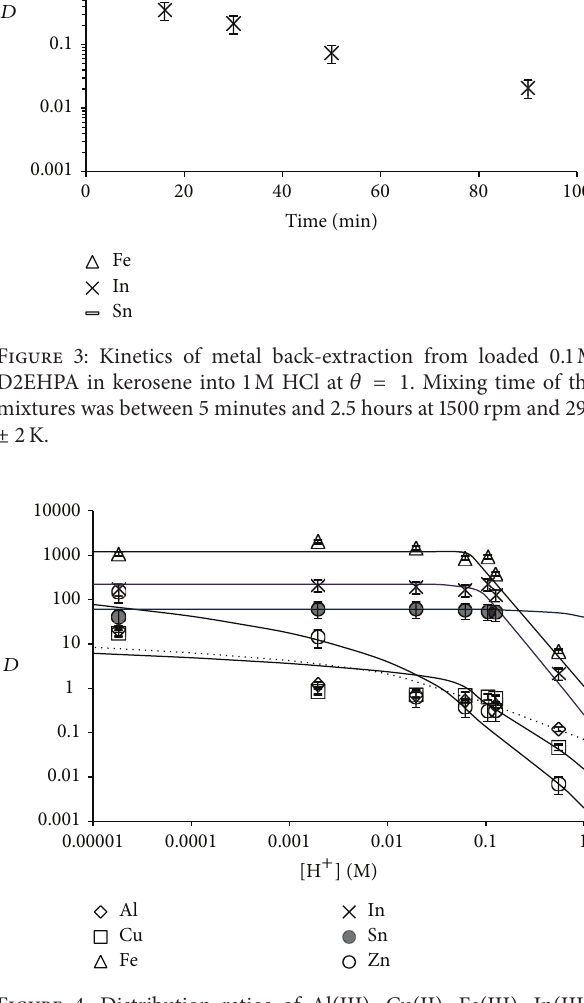
Figure 4: Distribution ratios of Al(III), Cu(II), Fe(III), In(III), Sn(IV), and Zn(II) in 1 M sulfate media at 293 K and 𝜃 = 1 plotted as a function of the hydrogen ion concentration. The organic phase was 0.1M D2EHPA diluted in kerosene.